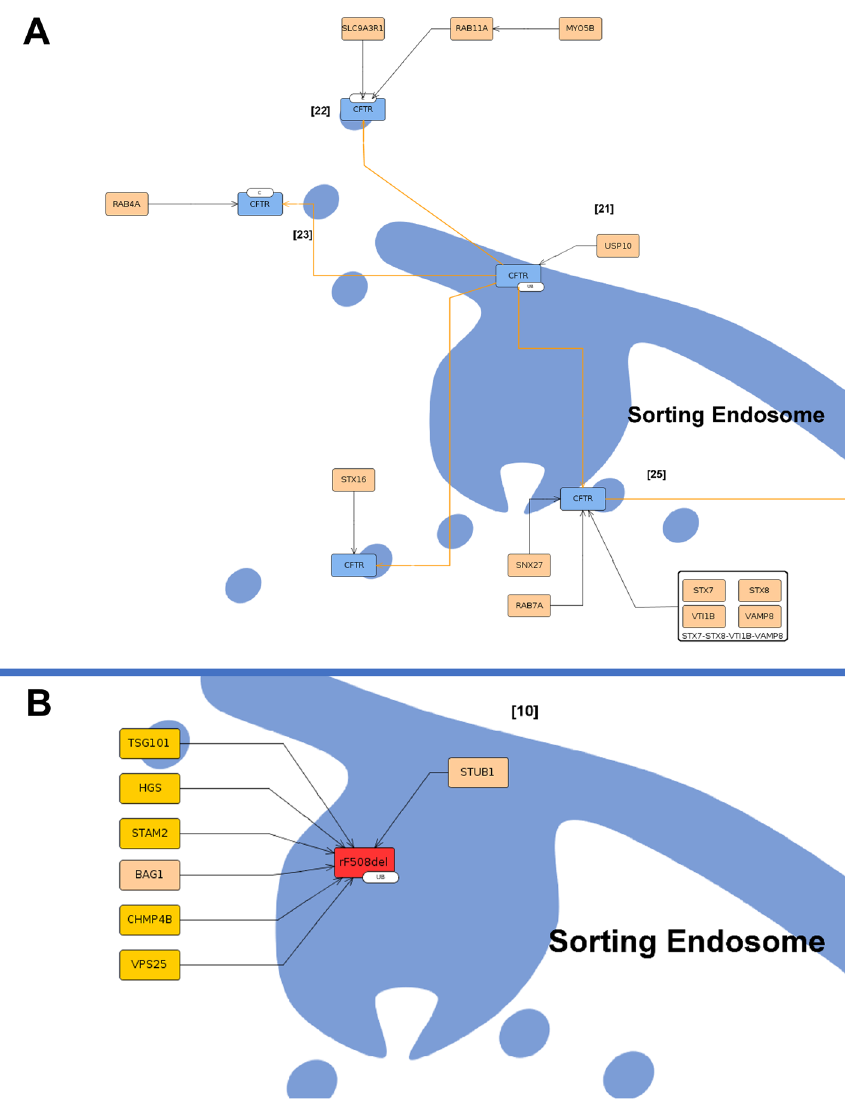
Figure 7. Sorting endosome in wt-CFTR ( A ) and F508del-CFTR ( B ) submaps. In the image ( A ), is possible to see wt-CFTR arriving at the sorting endosome [21] and the possible pathways to follow, either recycling [22], [23] and [24], or degradation [25] in orange lines. Bellow in image ( B ), rF508del-CFTR in red arrives at the endosome [10] in a complex with ubiquitin (represented with Ub) where several proteins target it to degradation directly, representing the low/absence of recycling of this protein. The proteins highlighted in yellow are unique to